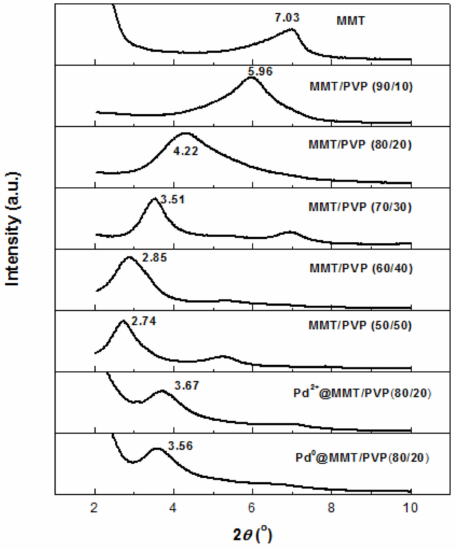
Figure 1. XRD patterns of MMT, MMT/PVP support and Pd@MMT/PVP catalytic